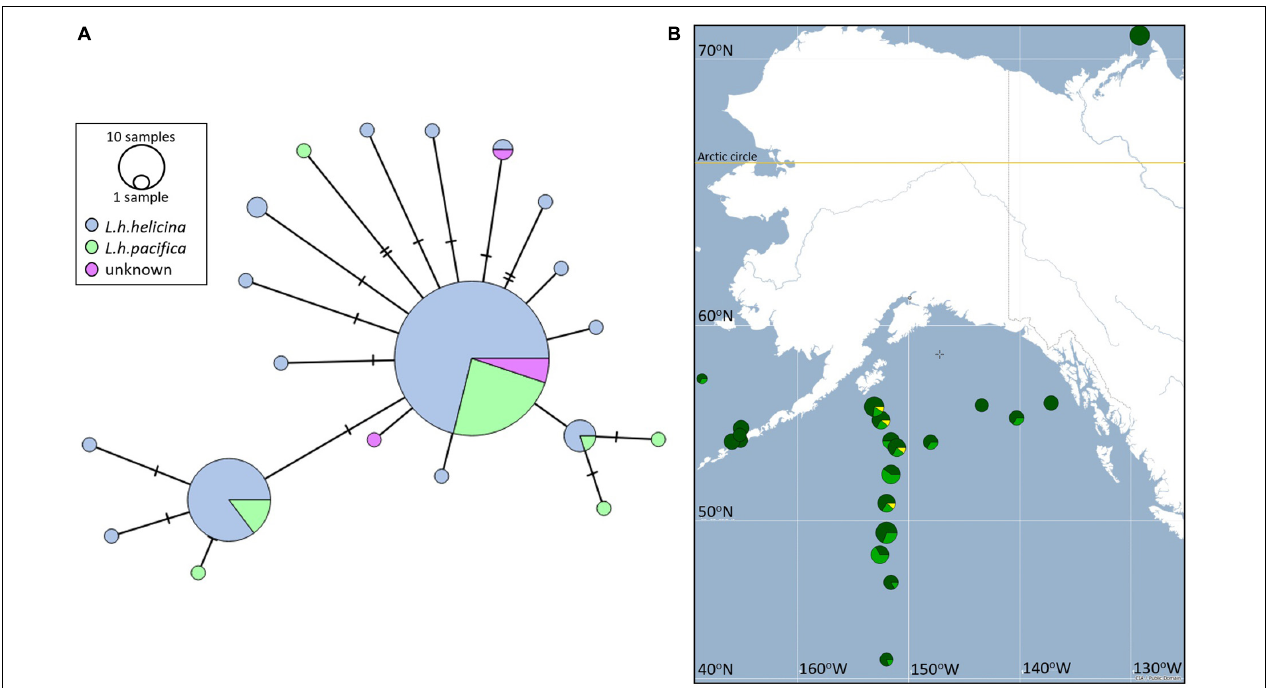
FIGURE 12 | (A) Minimum spanning network between 20 CO1 Haplotypes sequenced across 176 L . helicina morphotypes, sampled from the eastern North Pacific, GoA, Bering Sea and Amundsen Gulf. Haplotypes are joined by number of mutations (horizontal lines), circle sizes represent number of individuals representing each haplotype. The two morphotypes are represented in blue ( L.helicina helicina ) and green ( L. helicina pacifica ). Samples in purple could not be phenotyped. (B) Distribution of the three most common COI haplotypes across sampling stations in the Eastern Pacific subpolar gyre, GoA, Bering Sea and the Amundsen Gulf.